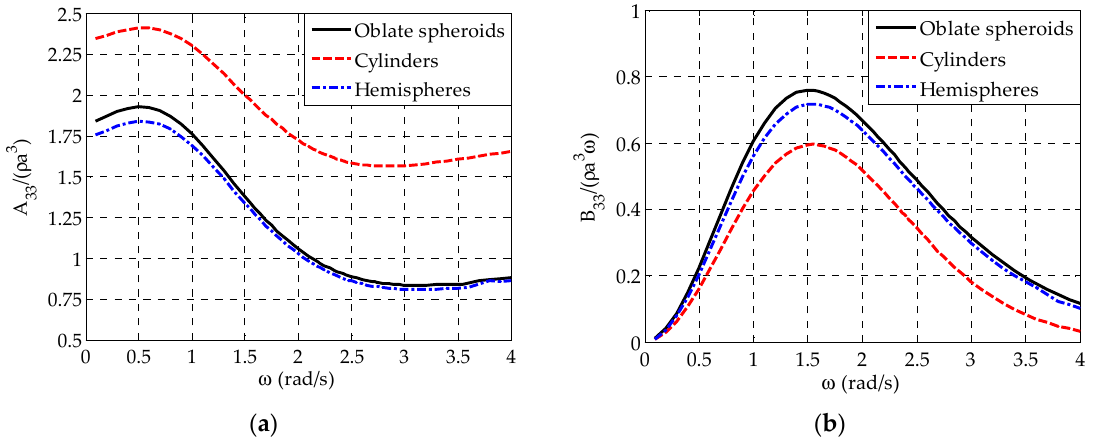
Figure 3. Variation of non-dimensional hydrodynamic coefficients in heave for the WEC geometries considered (results correspond to single isolated bodies): ( a ) Added mass and ( b ) radiation damping. Table 1. Geometrical and b PTO characteristics of WEC geometries considered. Geometry/Shape